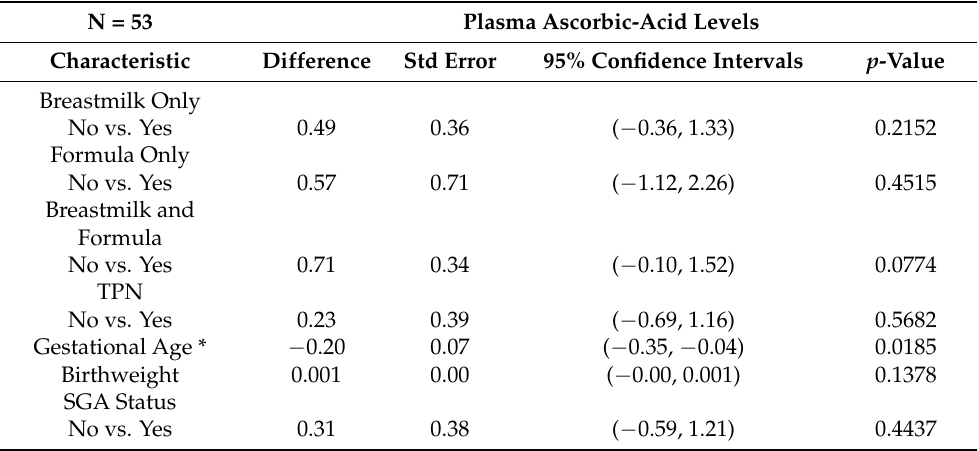
Table 5. Relationship between plasma ascorbic-acid levels during the first week of life and type of nutrition provided.